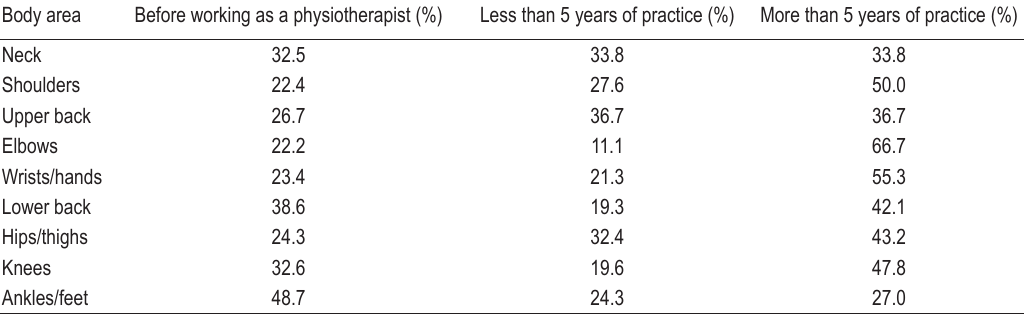
TABLE 4. First problems occurrence Body